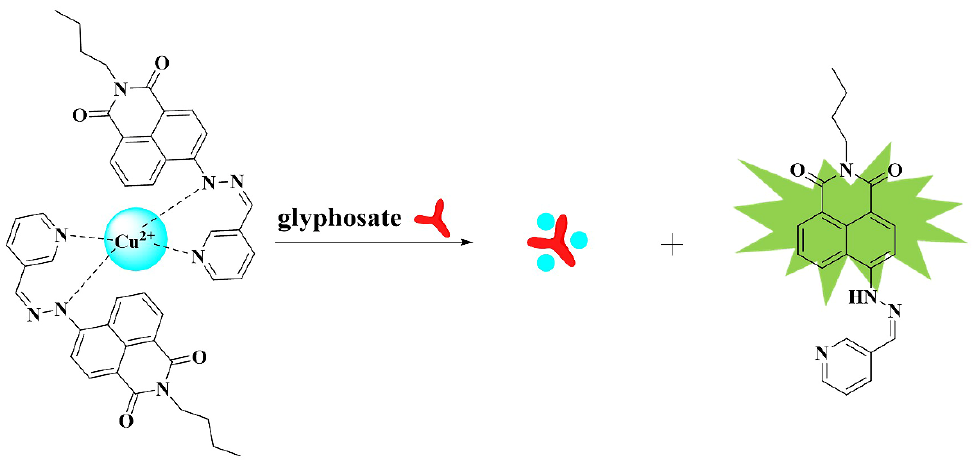
6 of 14 Figure 6. Frontier orbital energy diagram and electron transfer path in NPA and NPA−Cu 2+ . 2.2. Sensing Assay for Glyphosate by NPA−Cu 2+